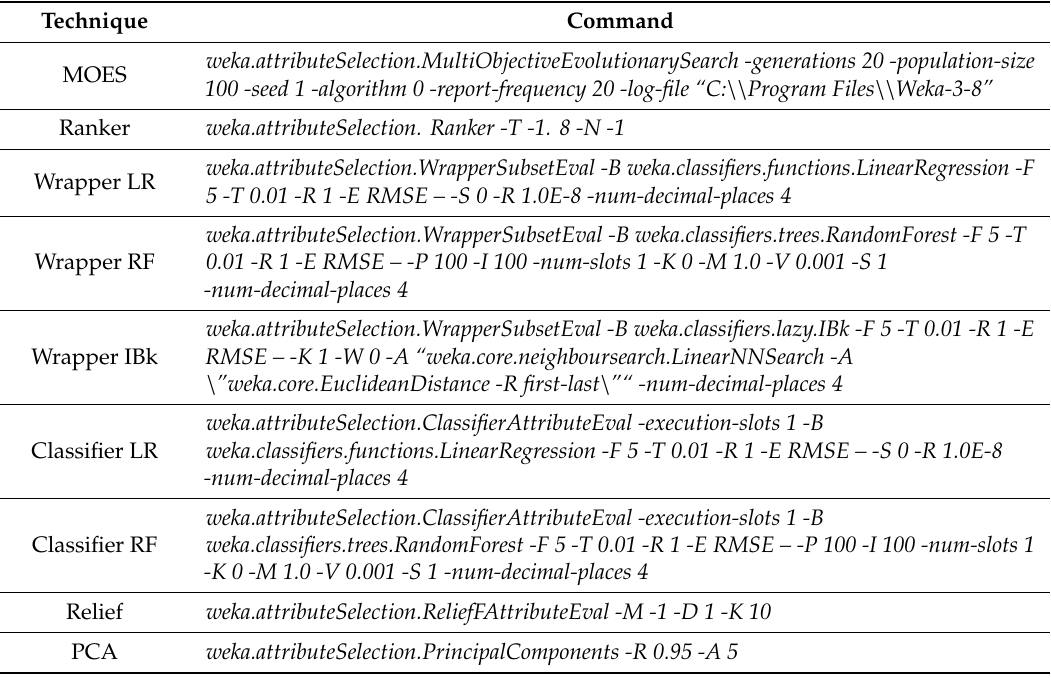
Table 3. WEKA commands for Feature